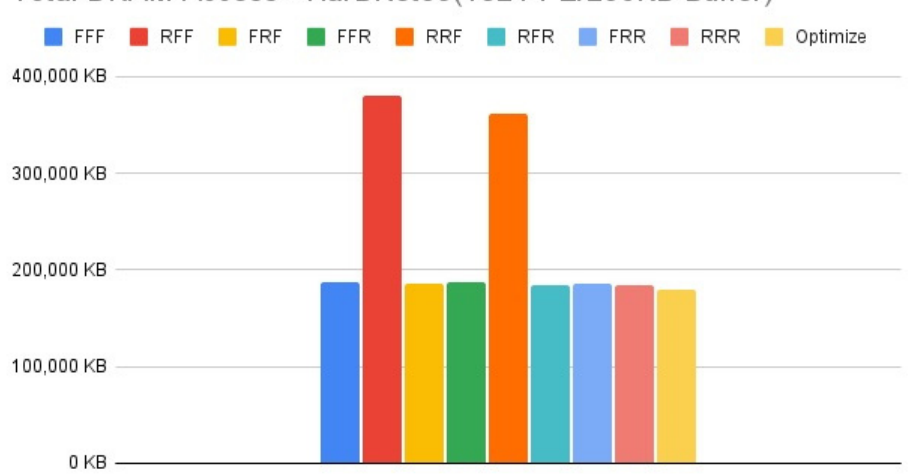
Figure 12. Total DRAM access—HarDNet39 (1024 PE/256 KB Buffer).